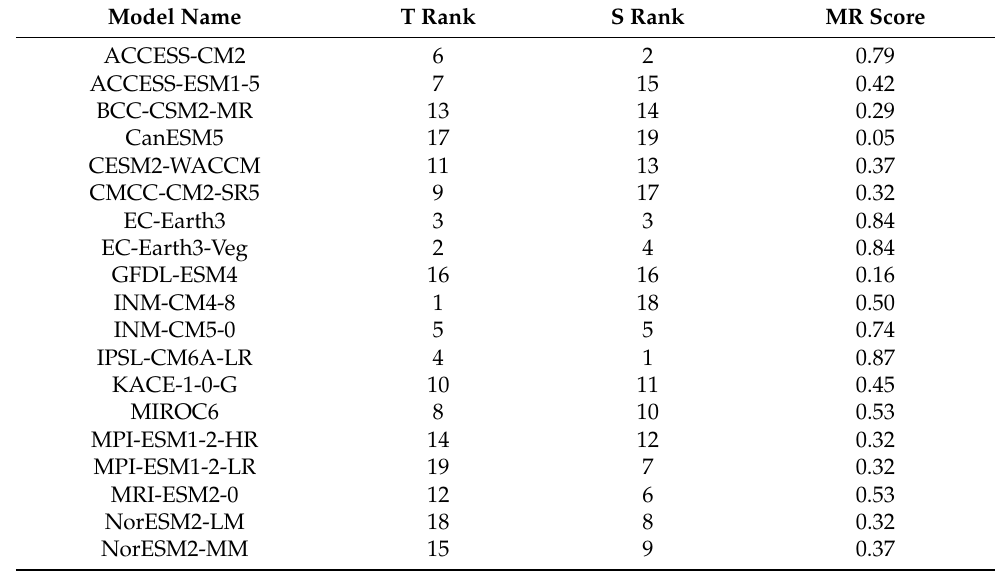
Table 2. Ranking of precipitation simulation capability of 19 models.